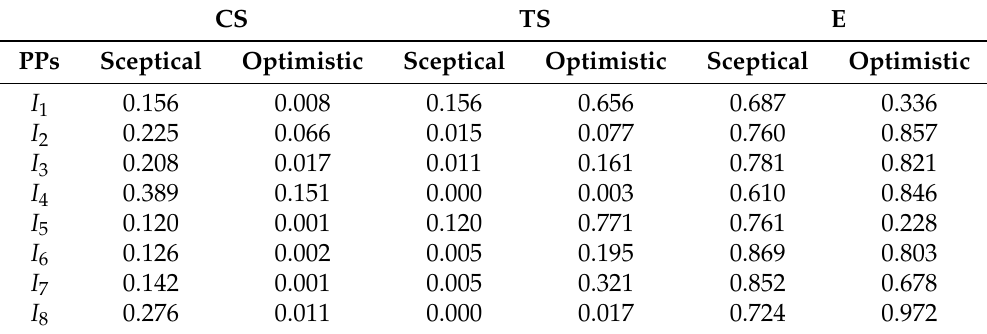
Table 3. The probabilities of CS, TS, and E for the eight predictive powers under the sceptical or optimistic